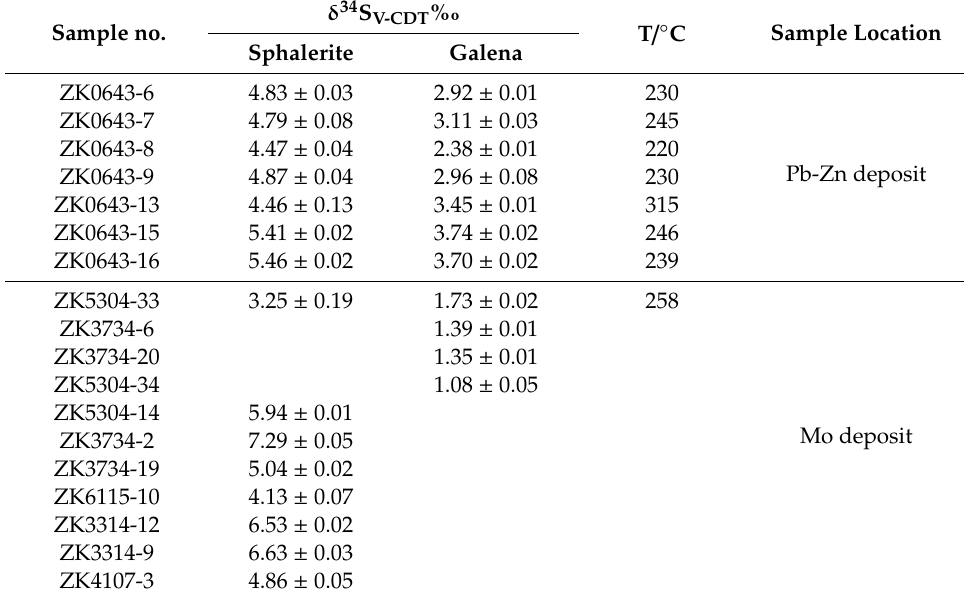
Sulfur isotopic composition of the sulfides from Pb-Zn and Mo deposits in the Diyanqinamu